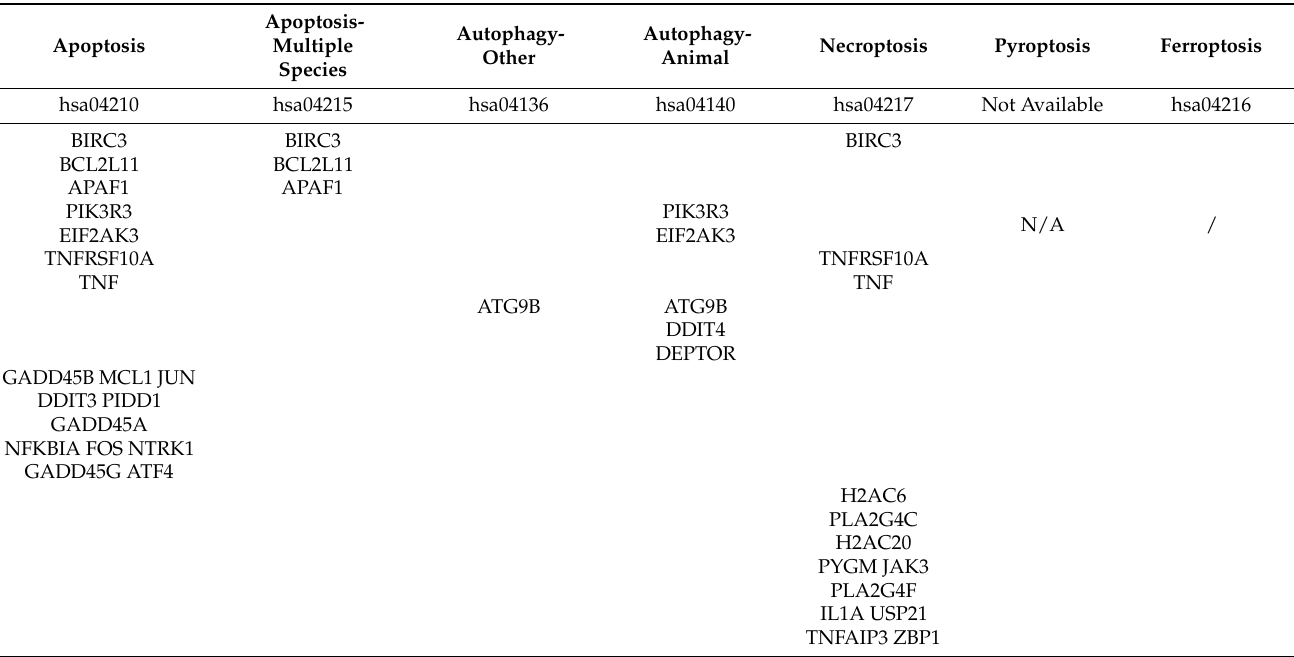
Table 1. Distributions of the screening 31 possible RCD-related differential expression genes among RCD forms (not counting ICD-related genes).